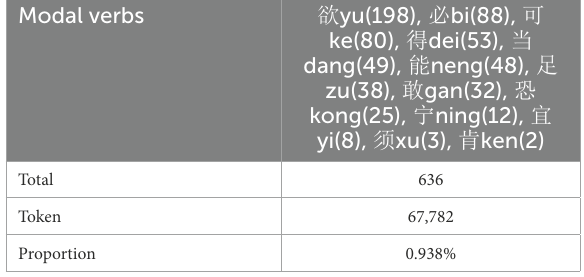
TABLE 3 Common modal verbs in the original text corresponding to the three translations. Modal verbs